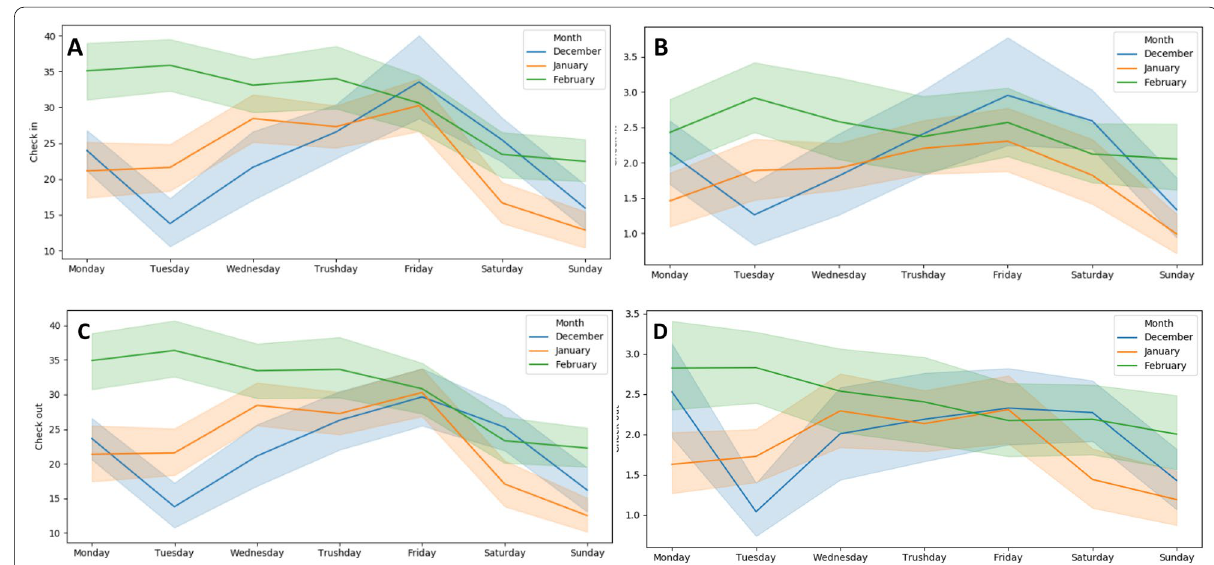
Fig. 16 Volume of check-ins and check-outs for all GIRA bike stations ( a , b ) and the IST cluster of three stations ( c , d ): average number per weekday (and associated bounds) along three consecutive